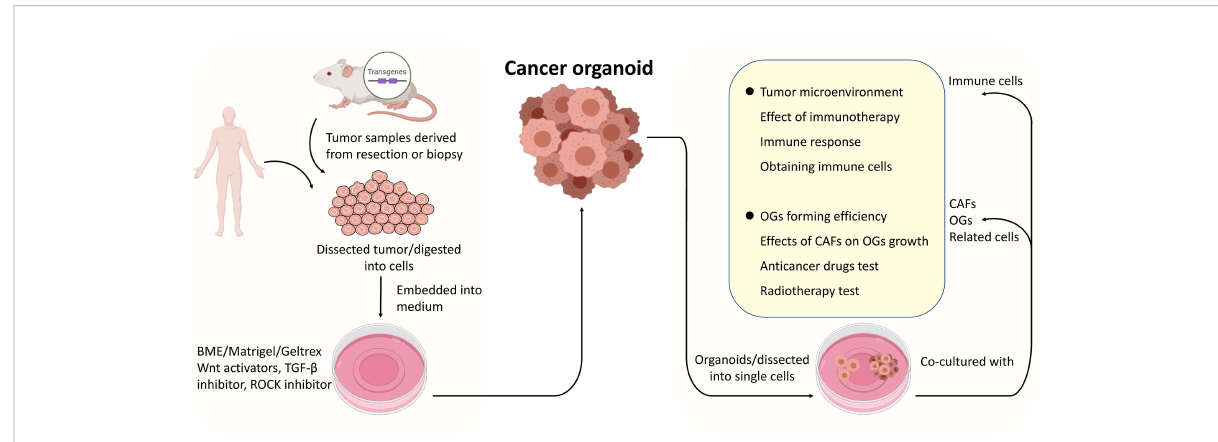
FIGURE 2 The procedures of cancer organoids establishment and applications of the co-culture system. Tumor tissues derived from surgically resected tumors or biopsies were dissected into small pieces or digested into cells, mixed with Matrigel, and cultured in media supplemented with speci fi c growth factors. Cancer organoids (dissected into cells or not) were co-cultured with organoids, cancer-associated fi broblasts or related cells primarily immune cells to model the interactions between speci fi c cells within tumors or